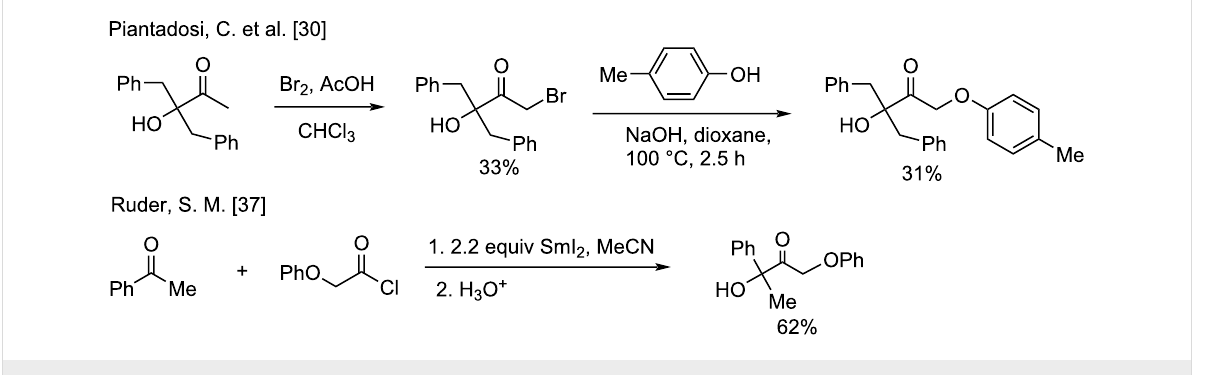
Scheme 9: Examples of representative preparation of phenoxyketones 4